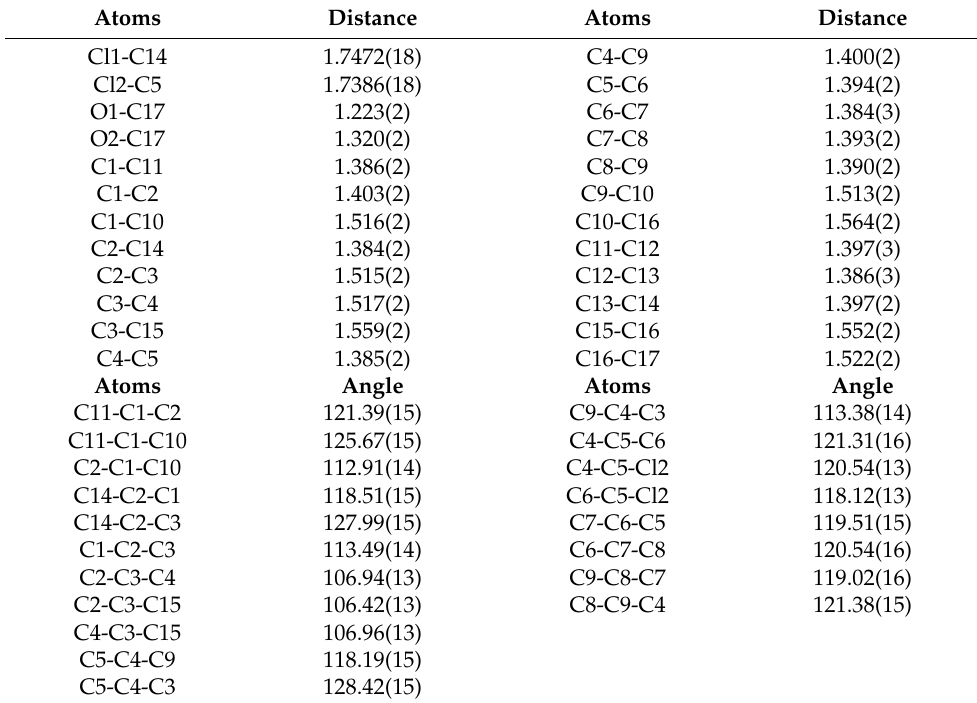
Figure 1. Molecular structure of 5 with anisotropic displacement ellipsoids drawn at the 50% probability level. Table 2. Selected bond lengths [Å] and angles [°] for 5 .